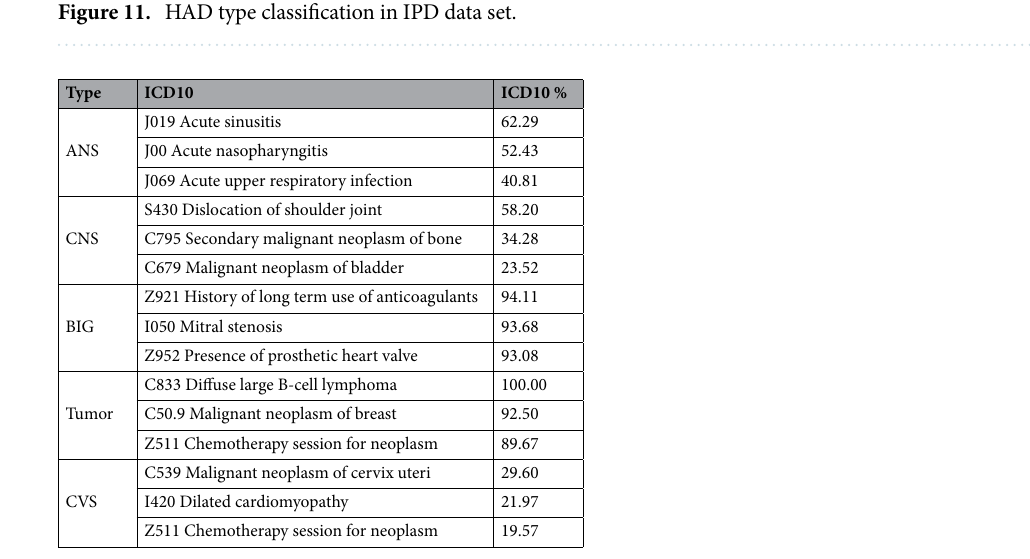
Table 16. The three highest numbers of ICD10 percent for each HAD type in OPD data